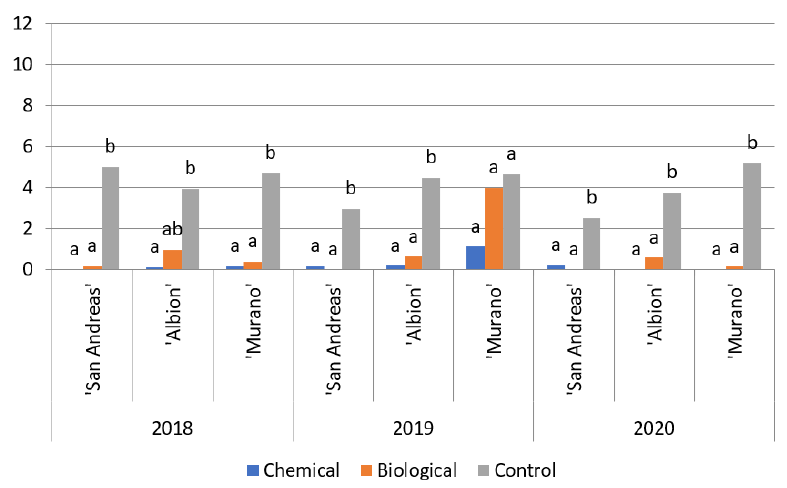
Figure 5. Percentage of fruit infected by Rhizopus and Mucor fungi among fruit waste at harvest [%]. Bars on which the same letter follows within a cultivar for each year are not significantly different at p ≤ 0.05.